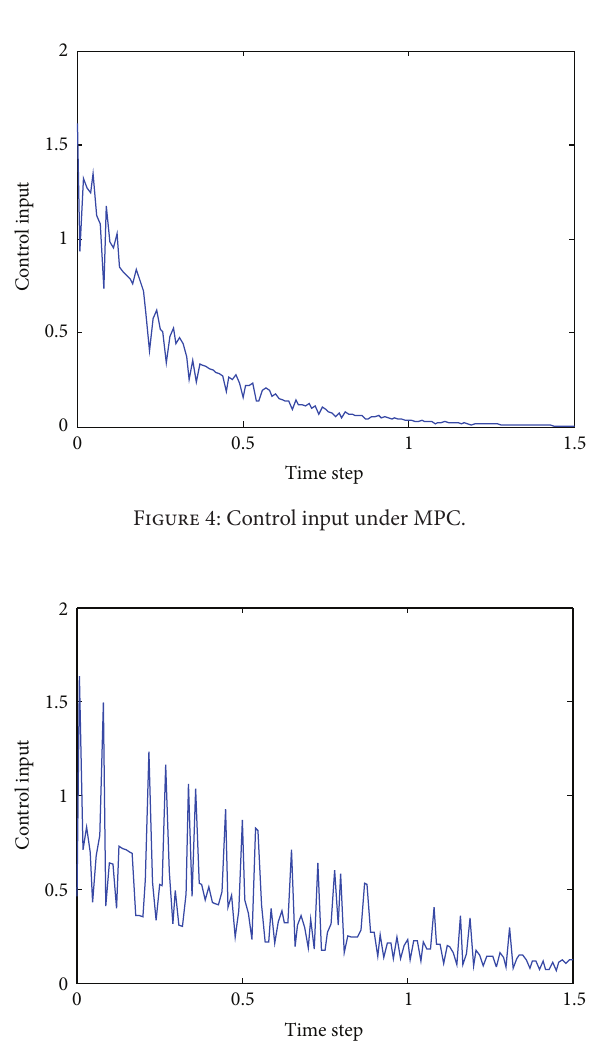
Figure 5: Control input under normal state feedback